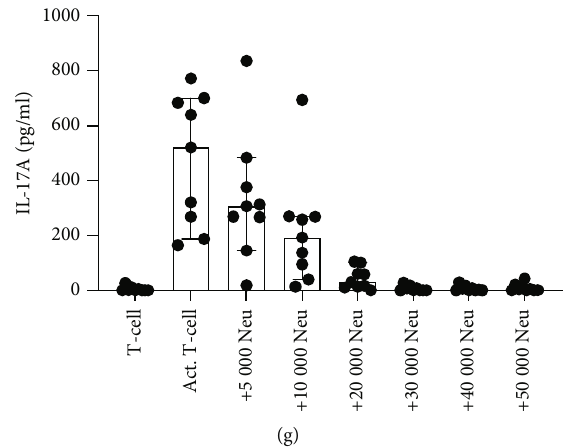
Figure 5: NDGs suppress cytokine production of Th cells in a dose-dependent manner. T-cells (100 000/well) were cocultured with di ff erent amounts of NDGs (5000, 10 000, 20 000, 30 000, 40 000, or 50 000/well). After 3 days of coculture, the supernatant was saved and used in a CBA to measure the presence of (a) IL-2, (b) IL-4, (c) IL-6, (d) IL-10, (e) TNF, (f) IFN-g, and (f) IL-17A. Graphs show median with 95% CI ( n = 9